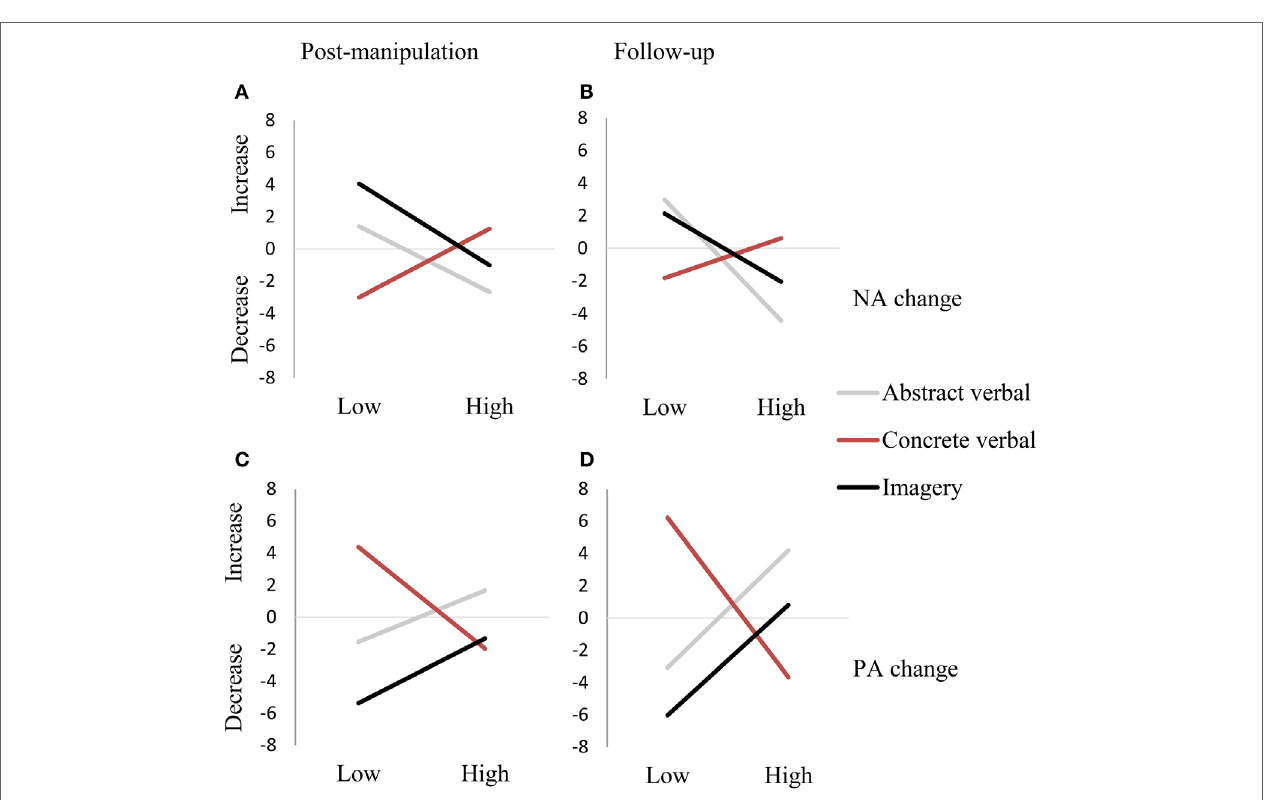
FigUre 2 | inspection of the three-way interaction (time × condition × depressive symptomatology), depicting change over time using a median split for depressive symptomatology for negative affective change at post-manipulation (a) and at follow-up (B) and for positive affective change at post-manipulation (c) and at follow-up (D) .